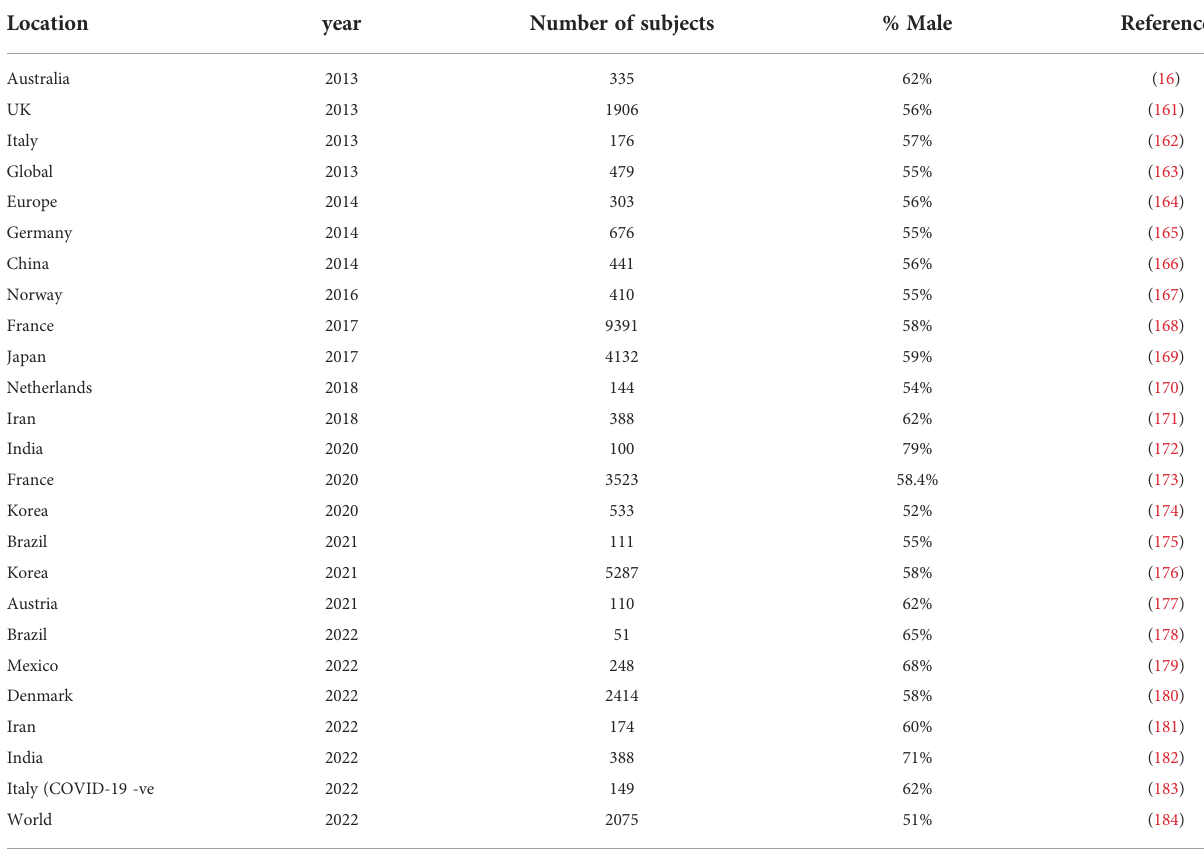
TABLE 4 Percentage of males in GBS series with 100 or more cases since